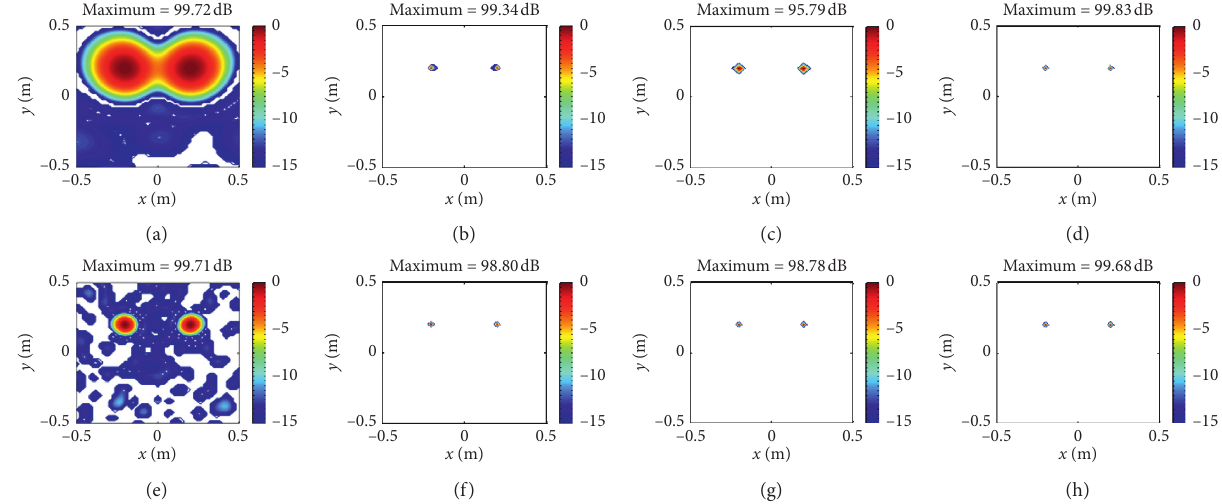
Figure 5: Contour maps of SPLs at 1m distance from the source using different algorithms at 40dB SNR. (a) CB at 2000Hz; (b) SC-DAMAS at 2000Hz; (c) FISTA at 2000Hz; (d) SFISTA at 2000Hz; (e) CB at 6000Hz; (f) SC-DAMAS at 6000Hz; (g) FISTA at 6000Hz; (h) SFISTA at 6000Hz.